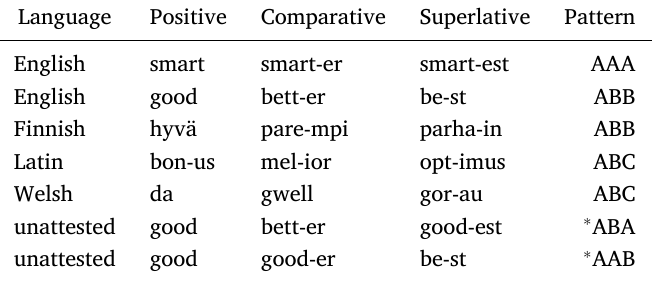
Examples of attested suppletion patterns from Smith et al. (2018)